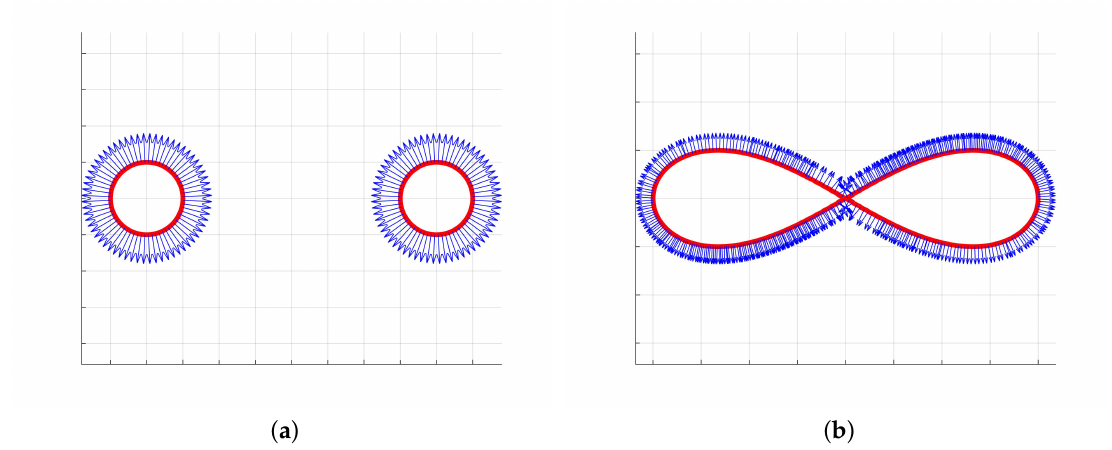
Figure 4. Upright Torus dataset (Figure 1). Morse level sets S O computed with our slicing algorithm. ( a ) Oriented contours with no critical points; ( b ) Oriented contour with non-degenerate saddle